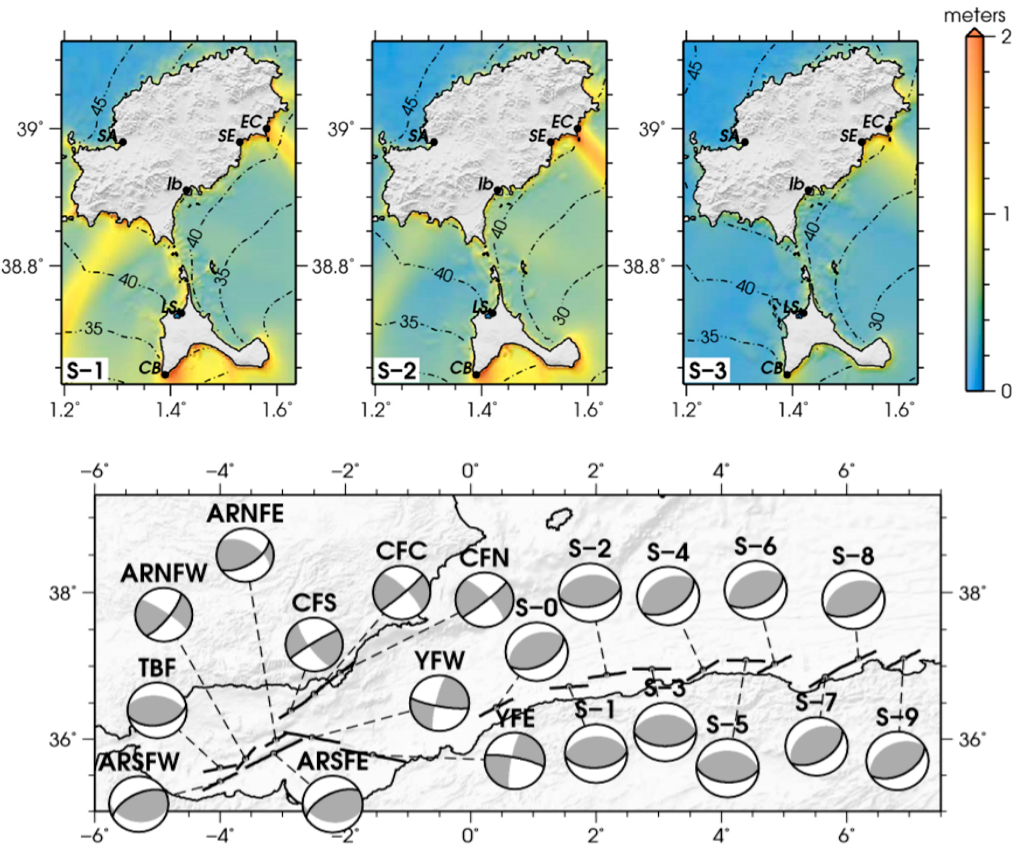
Figure 4. Maps of maximum wave elevation and estimated travel times of the tsunami in the islands of Ibiza and Formentera, according to the three of the tsunami sources defined by [19]. Below, seismic sources modelled as probable tsunamigenic worst cases for the westernmost Mediterranean coast (taken from [13]). The thick lines are the surface trace of the faults and the focal mechanisms represent the rupture characteristics. The black line of each double couple is the fault plane.